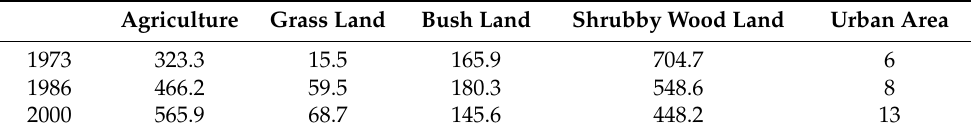
Table 2. Land use/ land cover changes in the catchment (units are in km 2 ) (After Abrha [67]). Agriculture Grass Land Bush Land Shrubby Wood Land Urban